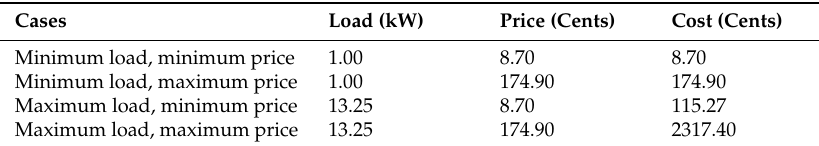
Table 7. Showing the possible formulated cases for